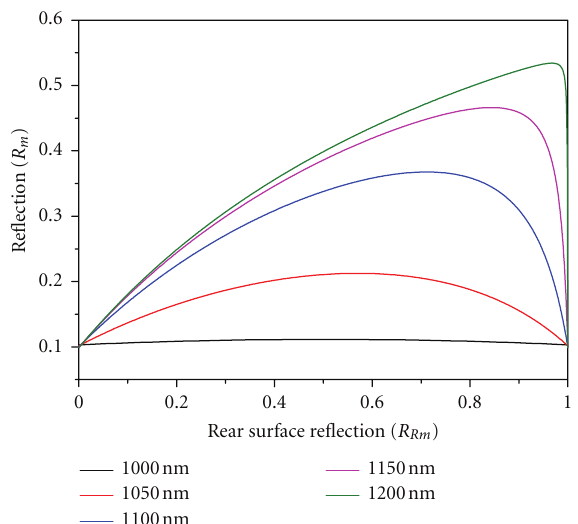
Figure 6: Reflection predicted by the model as a function of wavelength and surface morphology indictor h / D . The wafer thickness used in the simulations was 200 μ